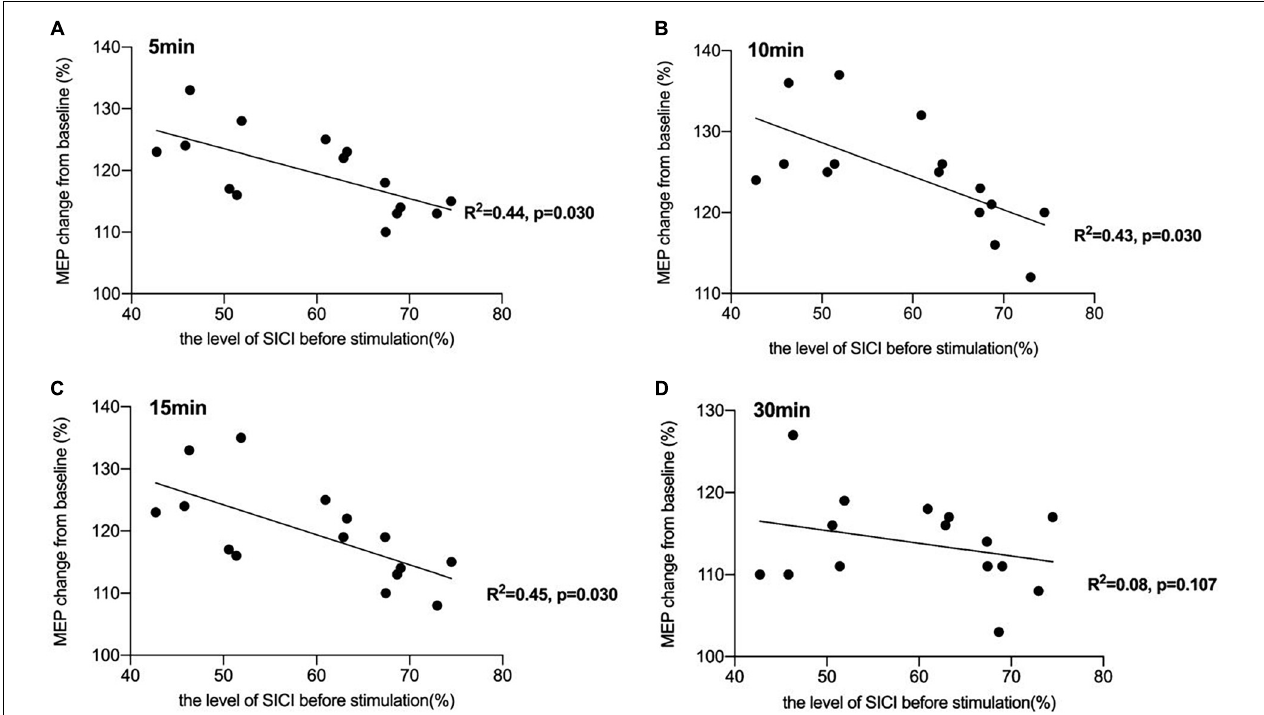
FIGURE 3 | Correlation between short-interval intracortical inhibitory (SICI) and the after-effect of intermittent theta burst stimulation (iTBS)-induced long-term potentiation (LTP)-like plasticity. (A) There was a significant negative correlation between the amount of SICI measured before iTBS and the after-effect of iTBS-induced LTP-like plasticity at the time point of 5 min [ R 2 = 0.44, p < 0.05, false discovery rate (FDR) corrected]. (B) The correlation between the level of SICI before stimulation and iTBS-induced after-effects at 10 min after conducting iTBS was also significant ( R 2 = 0.43, p < 0.05, FDR corrected). (C) A significant negative correlation was also reported between the amount of SICI before stimulation and the iTBS-induced effects at 15 min after stimulation ( R 2 = 0.45, p < 0.05, FDR corrected). (D) There was no significant correlation between SICI before stimulation and iTBS effect at 30 min ( R 2 = 0.08, p = 0.107, FDR corrected).